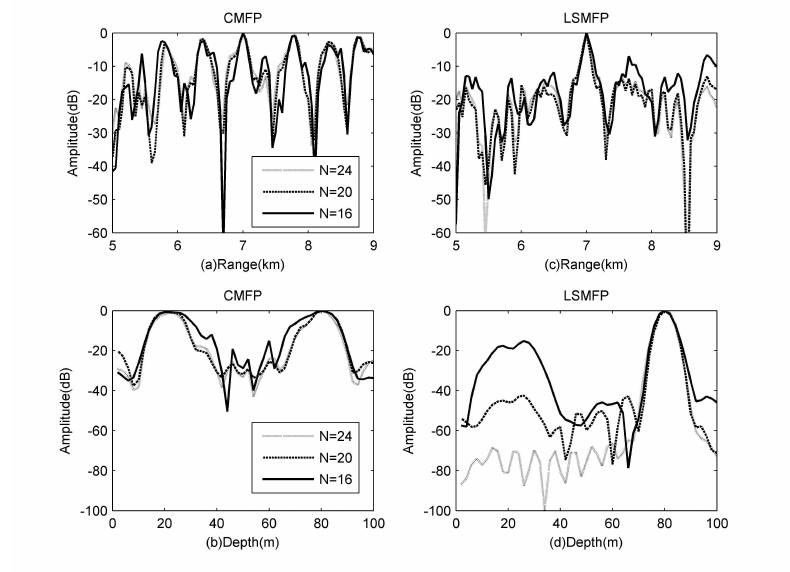
Figure 5. Localization slices of small arrays at the position of (7000 m, 80 m). ( a , b ) are the range and depth slices of CMFP; ( c , d ) are the range and depth slices of